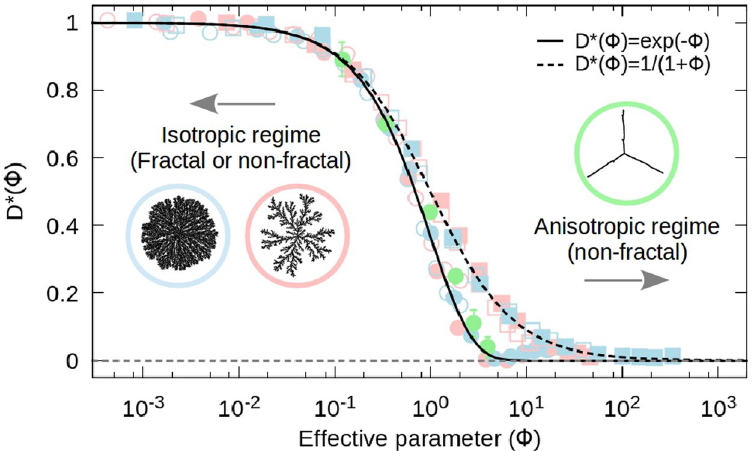
Figure 5. Universality. By plotting the reduced co-dimension D * as function of the effective parameter Φ , data for the scaling of the DLA-MF, BA-MF and DBM transitions collapse to universal curves given directly by equations (2) and (3). Under this description, these universal morphological transitions are independent of the fractal dimension of the initial configuration, D 0 , the symmetry-breaking process that drives the transition (including crossover effects), and, even, independent of the Euclidean dimension d of their embedding space. The scattered points were obtained by processing the data of Figs 3 and